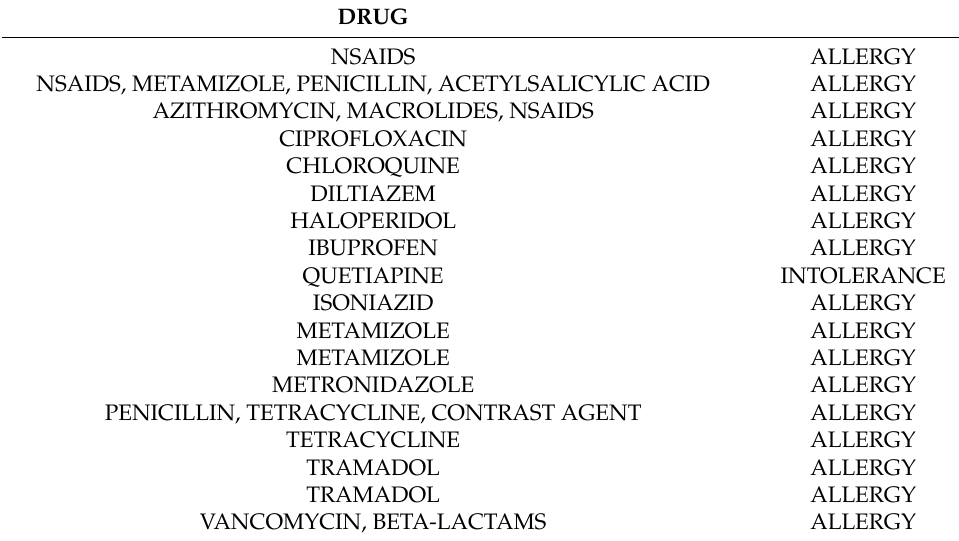
Table 2. History of ADRs.